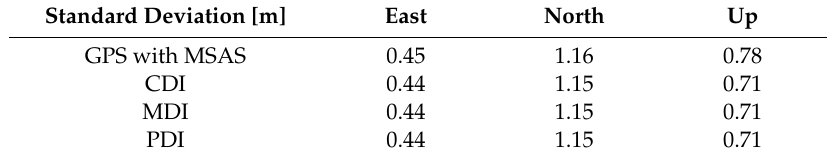
Table 1. Standard deviation of CDI, MDI, and PDI for single GNSS and multi-SBAS integration. Standard Deviation [m]